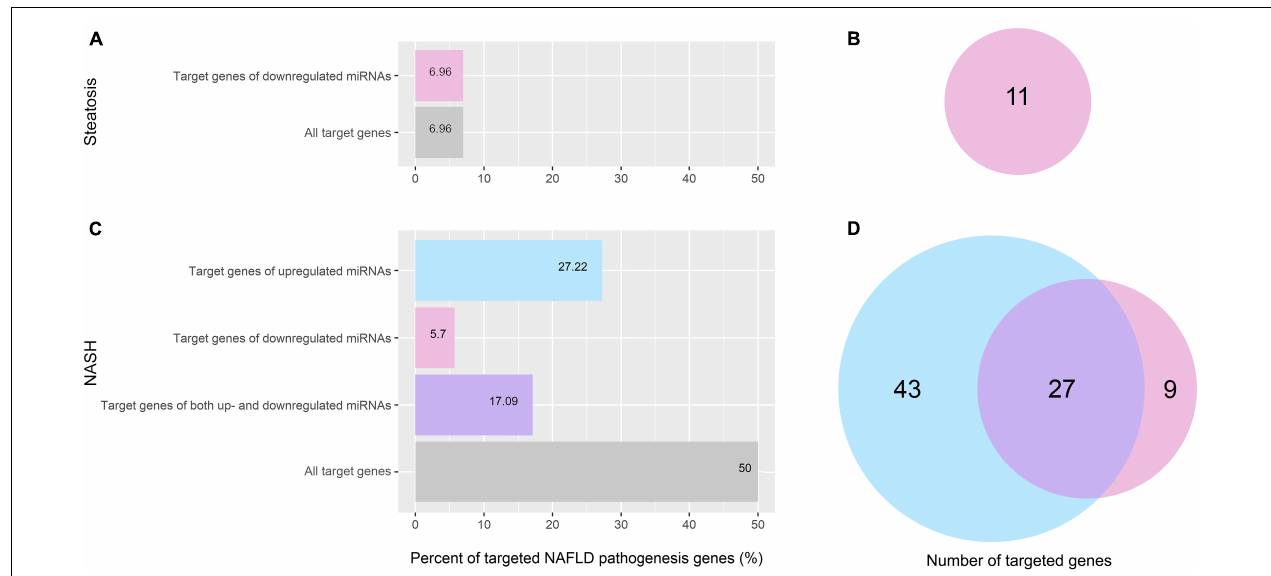
FIGURE 6 | Percentage and amount of NAFLD pathogenesis genes targeted by differentially expressed miRNAs. (A) Percentage of NAFLD pathogenesis genes targeted by differentially expressed miRNAs in the group of patients with steatosis; (B) Venn plot of NAFLD pathogenesis genes targeted by differentially expressed miRNAs in the group of patients with steatosis; (C) Percentage of NAFLD pathogenesis genes targeted by differentially expressed miRNAs in the group of patients with NASH; (D) Venn plot of NAFLD pathogenesis genes targeted by differentially expressed miRNAs in the group of patients with NASH. Pink—genes targeted by downregulated miRNAs; light blue—genes targeted by upregulated miRNAs; purple—genes targeted by both up- and downregulated